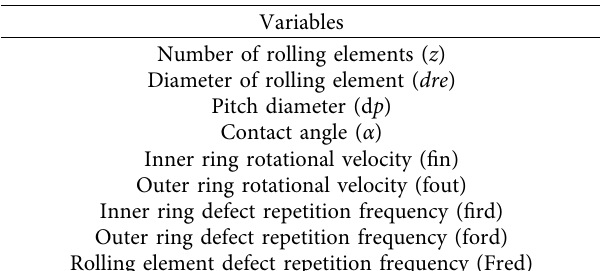
Figure 20: Vibration severity per ISO 10816. Table 4: Bearings’